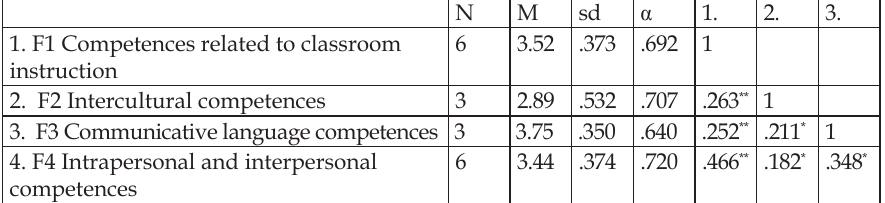
Table 3. Intercorrelations between scales and scale reliability coef fi